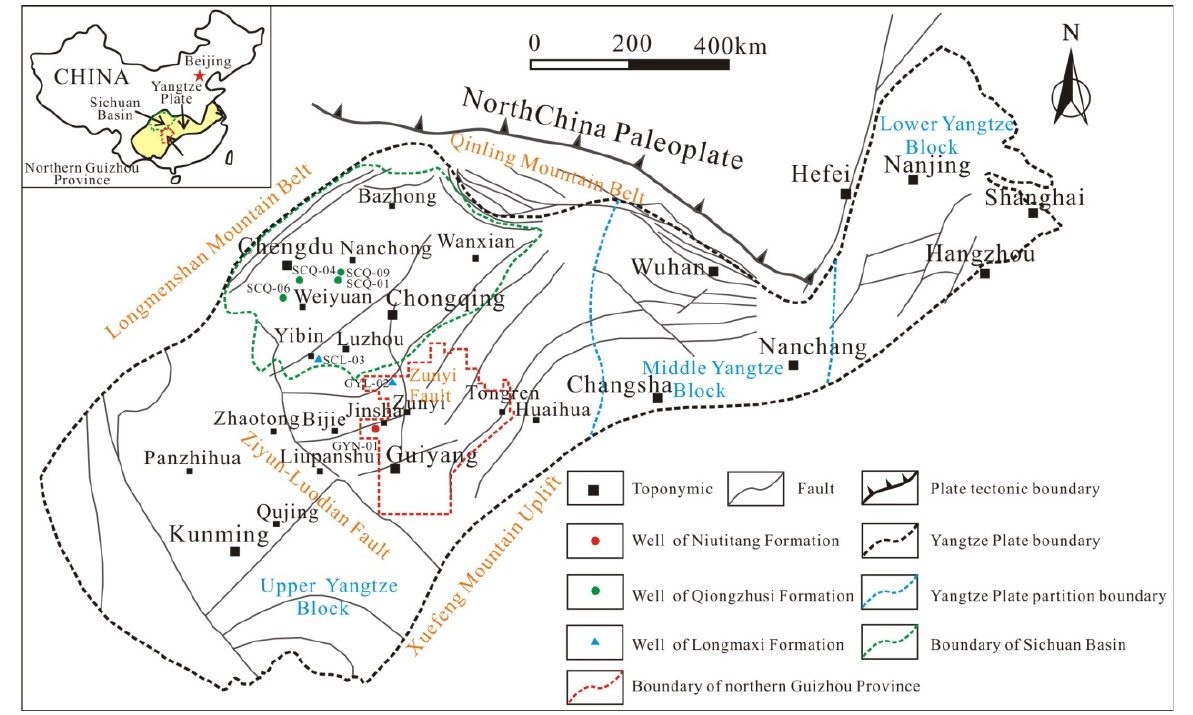
Figure 1. Well location distribution map of the upper Yangtze plate, South China.